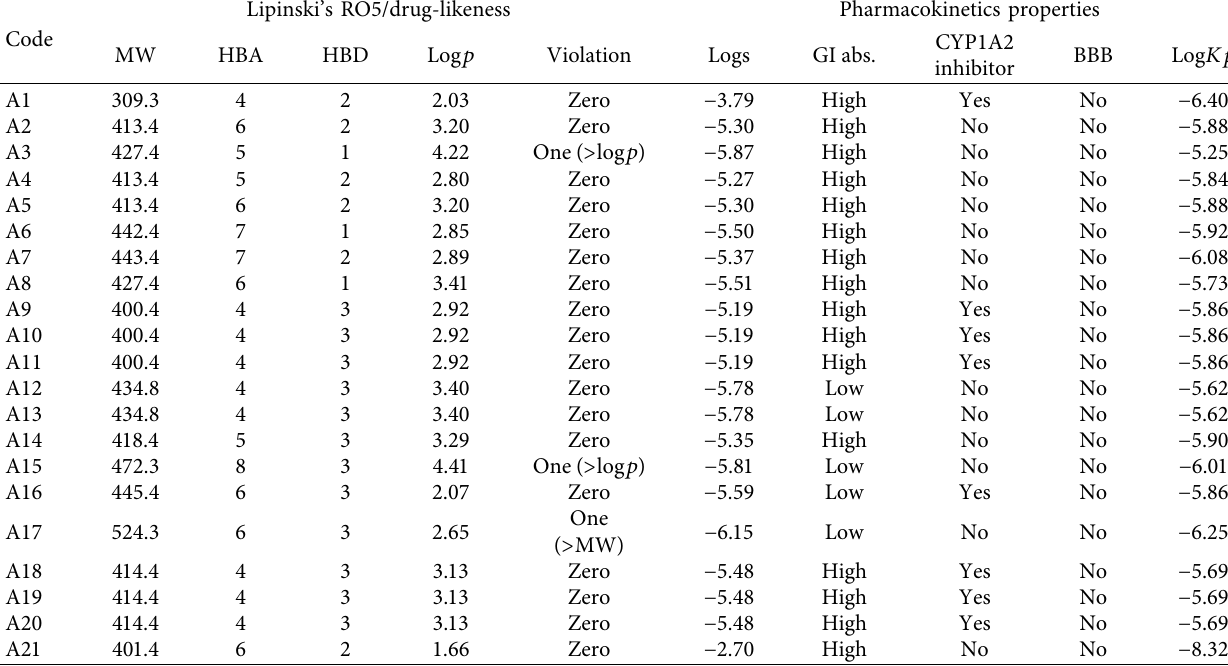
Table 4: Drug-likeness and pharmacokinetic